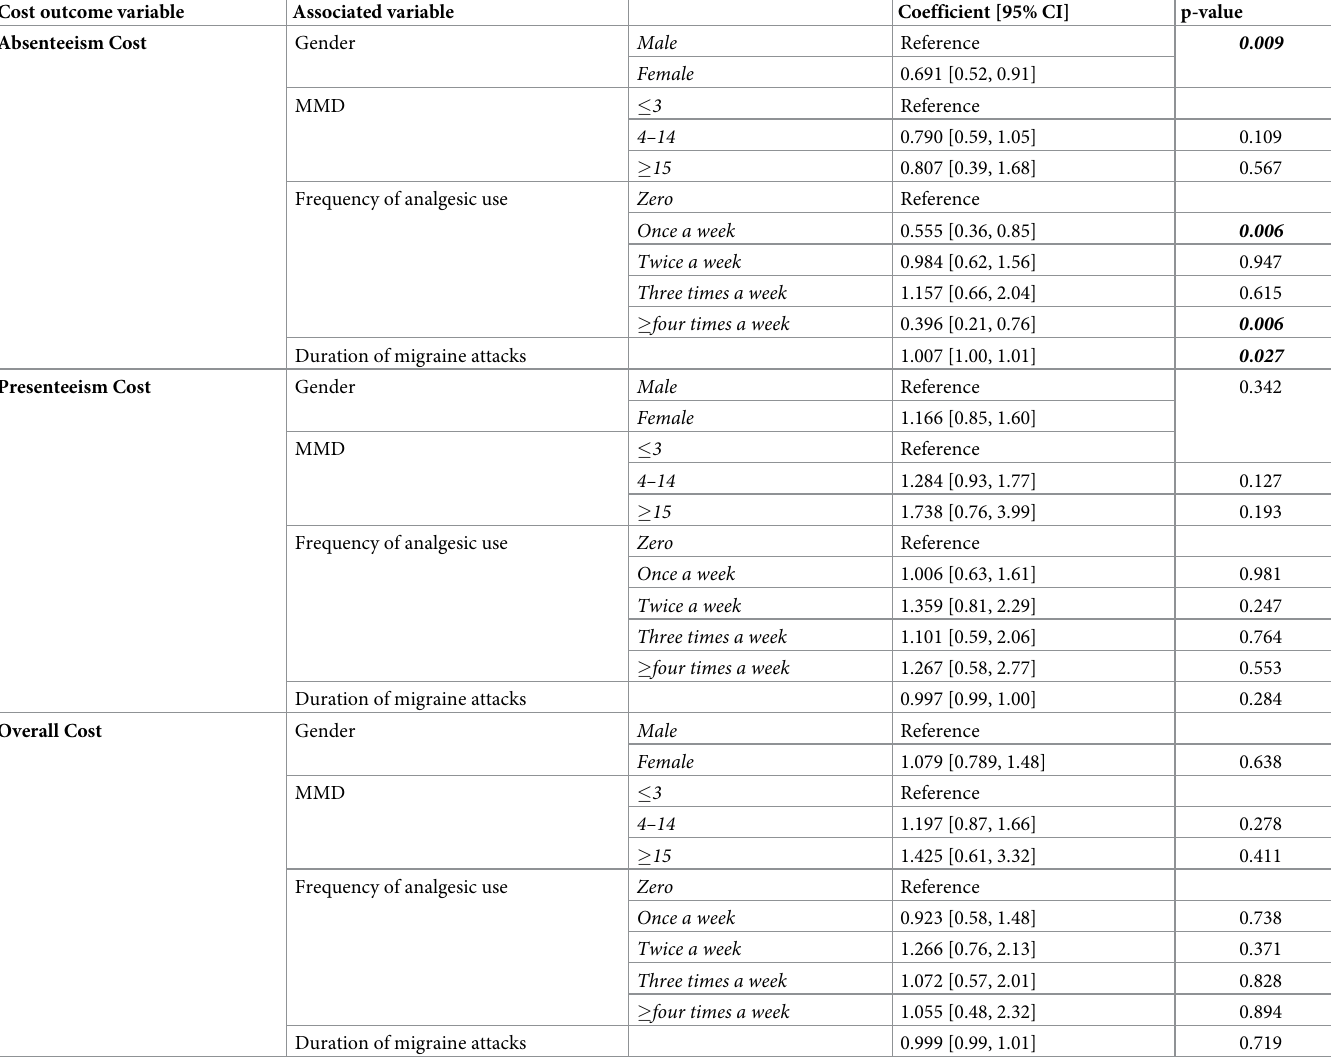
Table 2. Multivariate analyses about predictors for productivity loss cost among Korean migraine and probable migraine